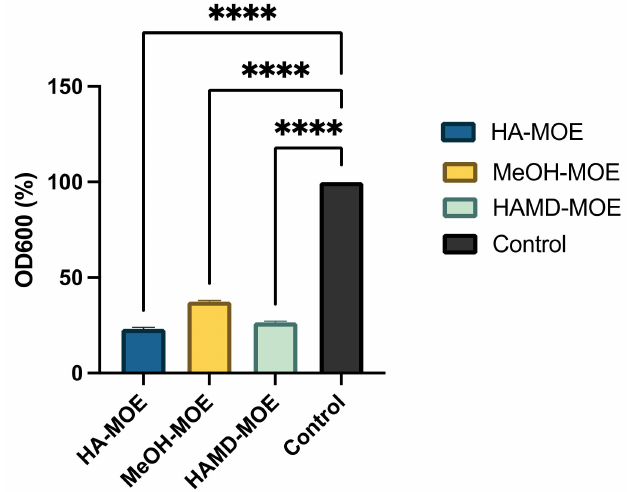
Figure 4. Effects of MOEs on biofilm formation: The Xcc biofilm was measured by OD 600 and presented as the percentage compared to the control. Data are the mean of 3 independent experiments performed on triplicate (mean +/- standard deviation), and values are represented as a percentage; **** p -values <